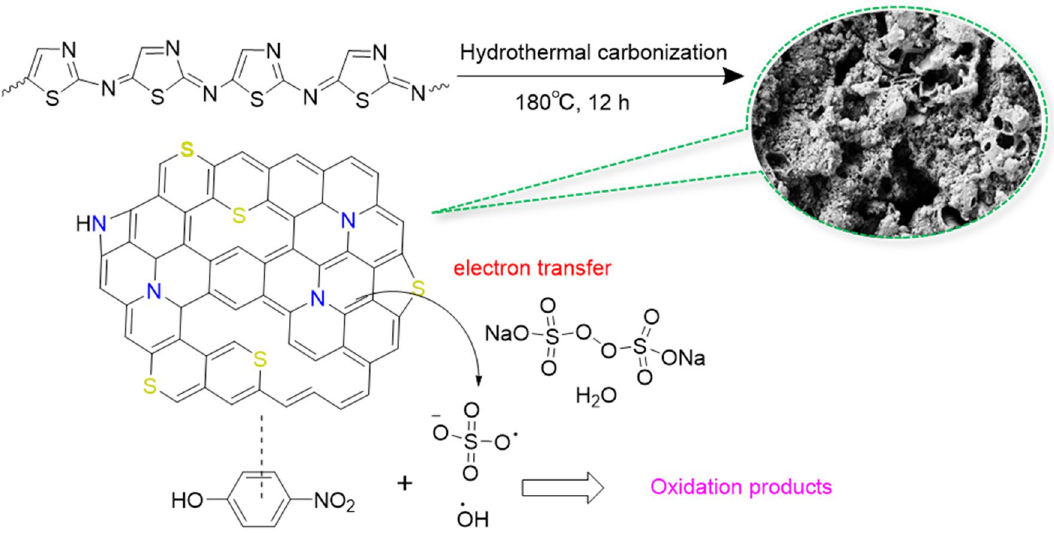
Figure 7. Schematic representation of 4-NP degradation using (N, S)-MPC as metal-free activator for persulfate-based AOP.